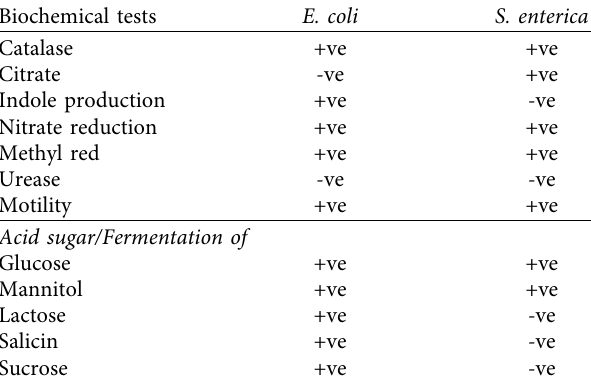
Table 1: Biochemical reactions for E . coli and S . enterica . Biochemical